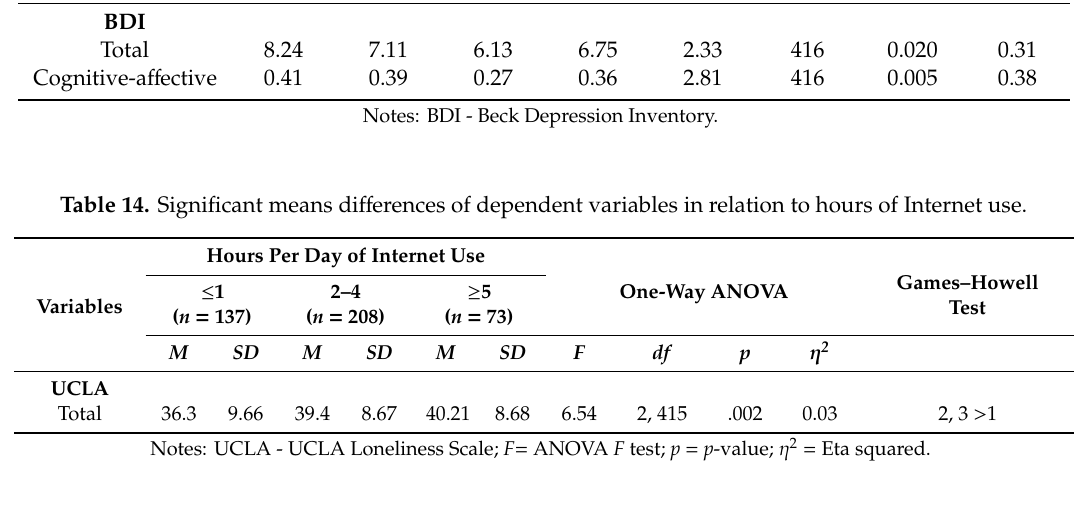
Table 13. Significant means di ff erences of dependent variables in relation to daily Internet use. Daily Internet Use Variables BDI